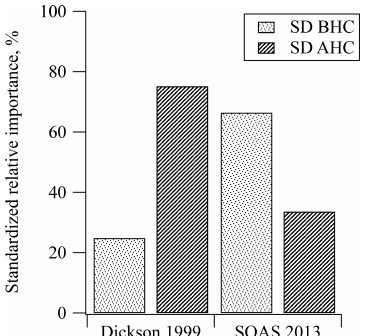
Figure 4. Comparison of standardized relative contribution to PAN formation from biogenic and anthropogenic hydrocarbons during the daytime in Dickson, TN, in 1999 and SOAS, in Centreville, AL, in 2013. The std. BHC and std. AHC mean standardized the relative importance of biogenic hydrocarbon and anthropogenic hydrocar- bon,